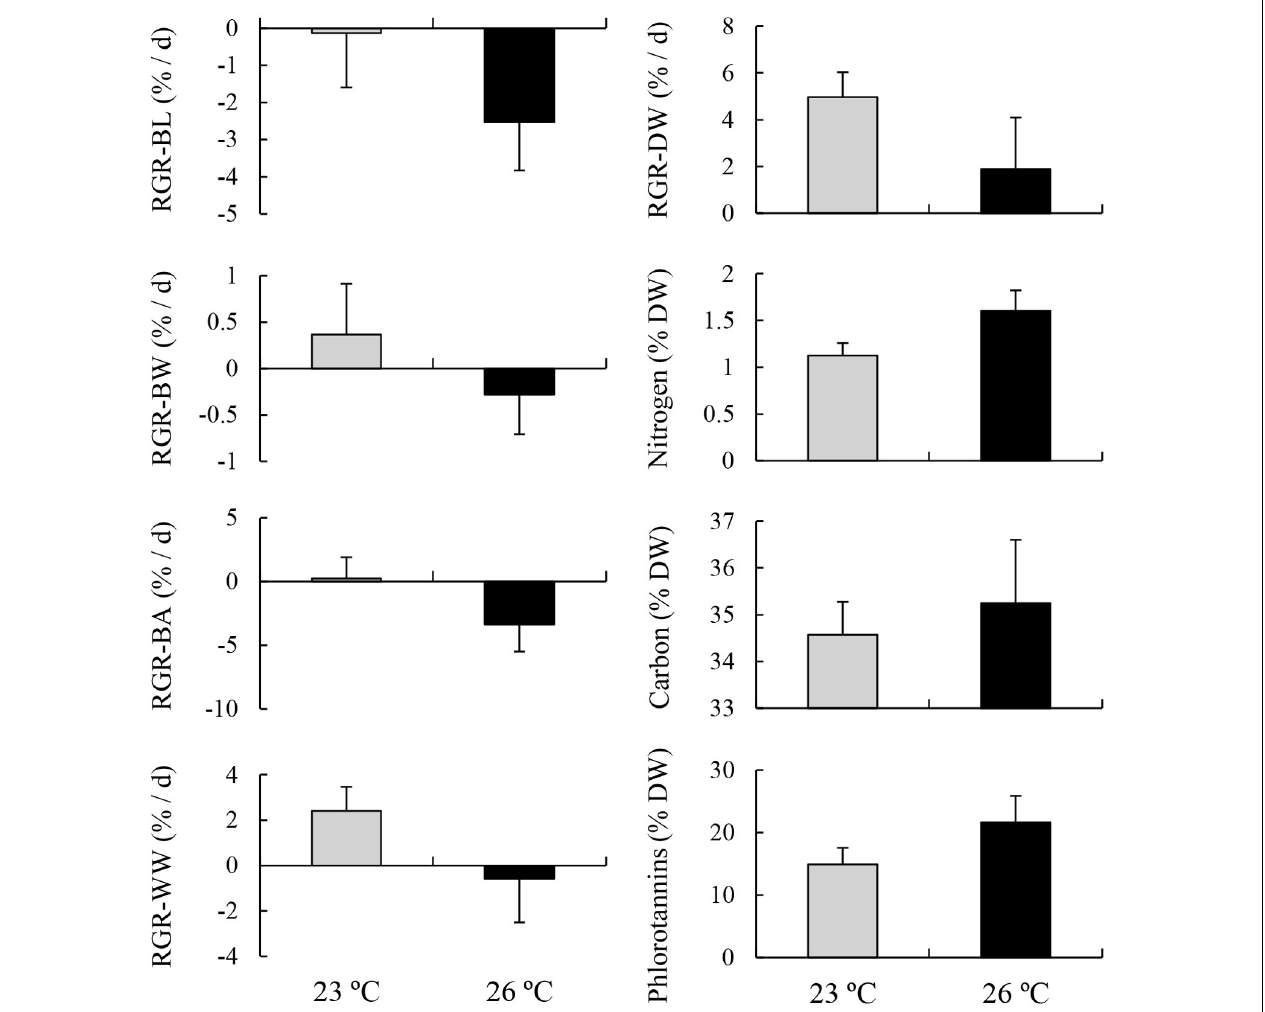
FIGURE 3 | Relative growth rates (RGRs) based on blade length (BL), blade width (BW), blade area (BA), wet weight (WW), and dry weight (DW), and contents of chemical compositions including nitrogen, carbon, and phlorotannins of E. bicyclis juvenile sporophytes cultured in two different temperature treatments (mean ± SD, n =